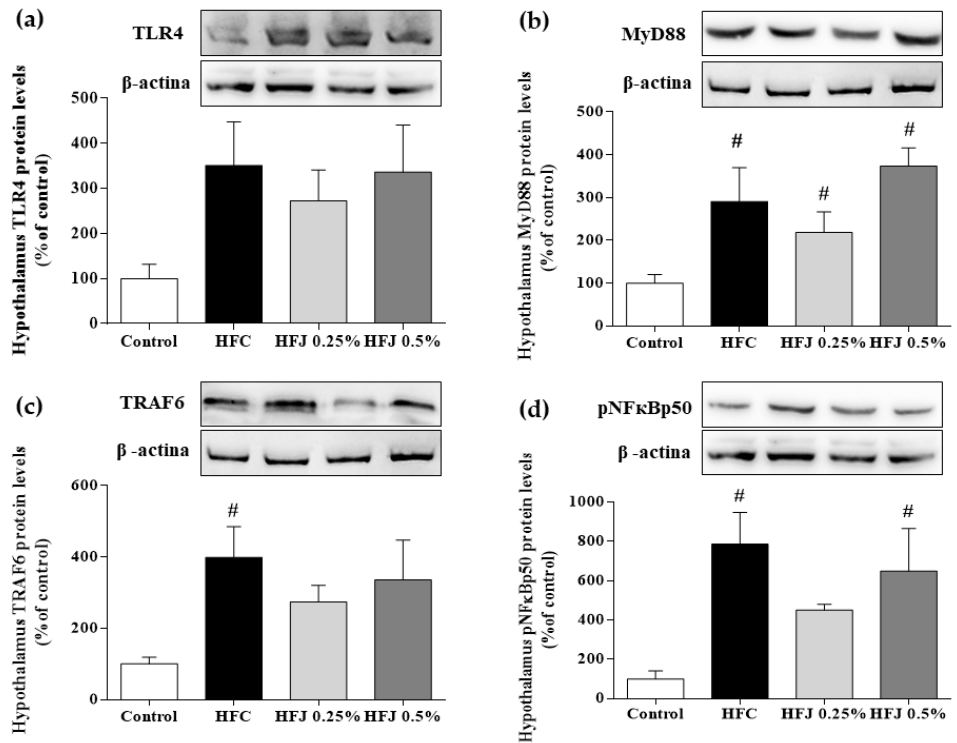
Figure 3. Protein expression in the NF- κ B pathway in the hypothalamus: ( a ) TLR4, ( b ) MYD88, ( c ) TRAF6, and ( d ) pNF- κ Bp50. The housekeeping used for all analyses was β -actin expression. * p < 0.05 compared with the high-fat juçara 0.25% (HFJ 0.25%) group; # p < 0.05 compared with the control diet (C) group ( n = 6).